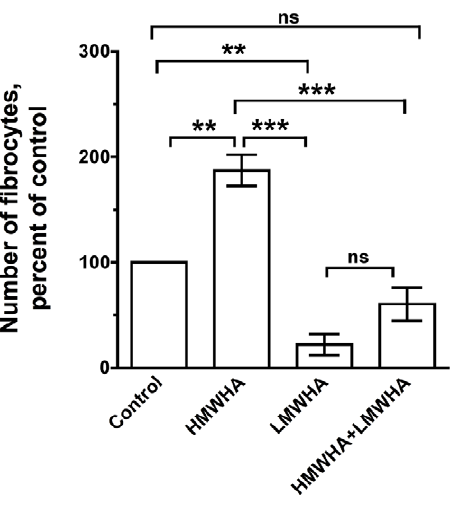
Figure 4. LMWHA inhibits HMWHA-induced fibrocyte differen- tiation. Human PBMC were cultured in SFM (control), SFM with 300 m g/ml HMWHA, SFM with 300 m g/ml LMWHA, or SFM with 300 m g/ ml HMWHA and 300 m g/ml LMWHA. After 5 days, the cells were air dried, fixed, stained, and the number of fibrocytes was counted. The results are mean 6 SEM of percent of control (n=3 separate experiments). The number of fibrocytes per 2.5 6 10 5 PBMC in controls from the 3 donors was 1525, 713, and 1290. * indicates p , 0.05, ** p , 0.01, *** p , 0.001 compared to control as determined by ANOVA. Using the non-parametric Mann Whitney two-tailed t-test, there is no